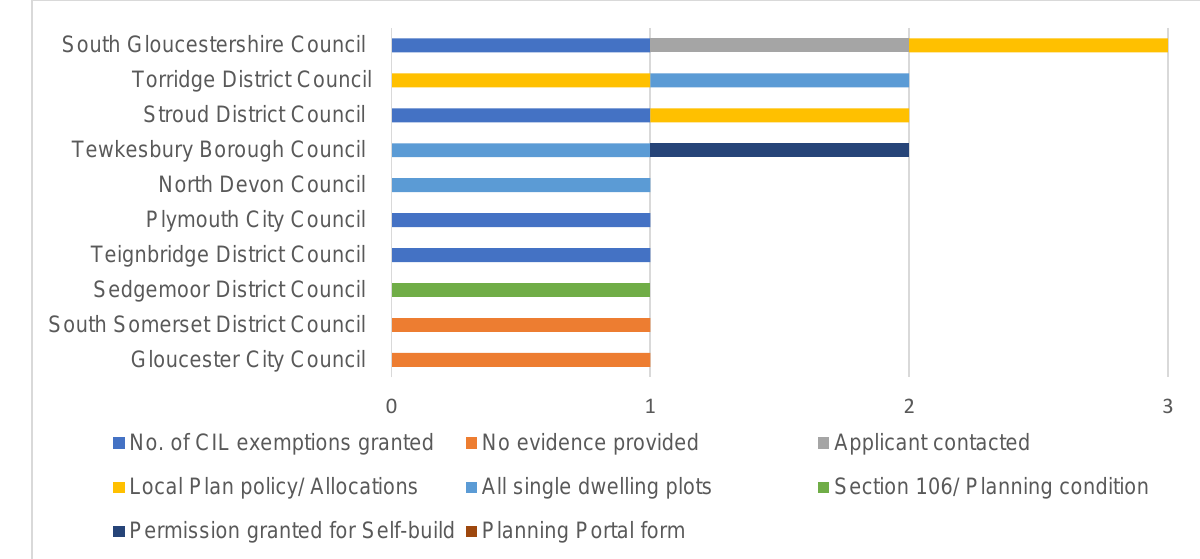
Figure 3. Indicators used to identify suitable development permissions granted. Source: LPA Freedom of Information Responses.